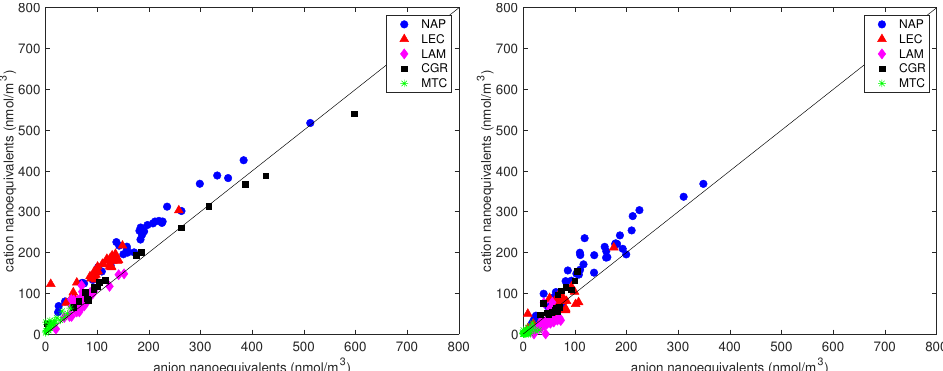
Figure 9. The charge balance between anions and cation equivalents for PM 10 ( left panel ) and PM 2.5 ( right panel ). The straight line is the 1:1